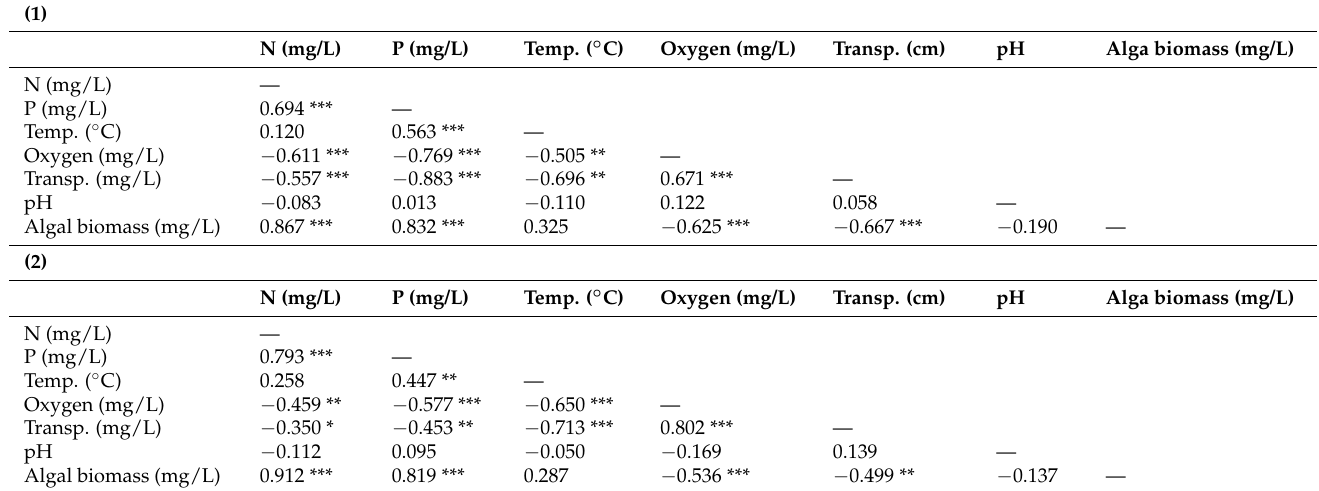
Note: Mean difference values with asterisk (*) are statistically significant different at * p < 0.05, ** p < 0.01, *** p < 0.001.